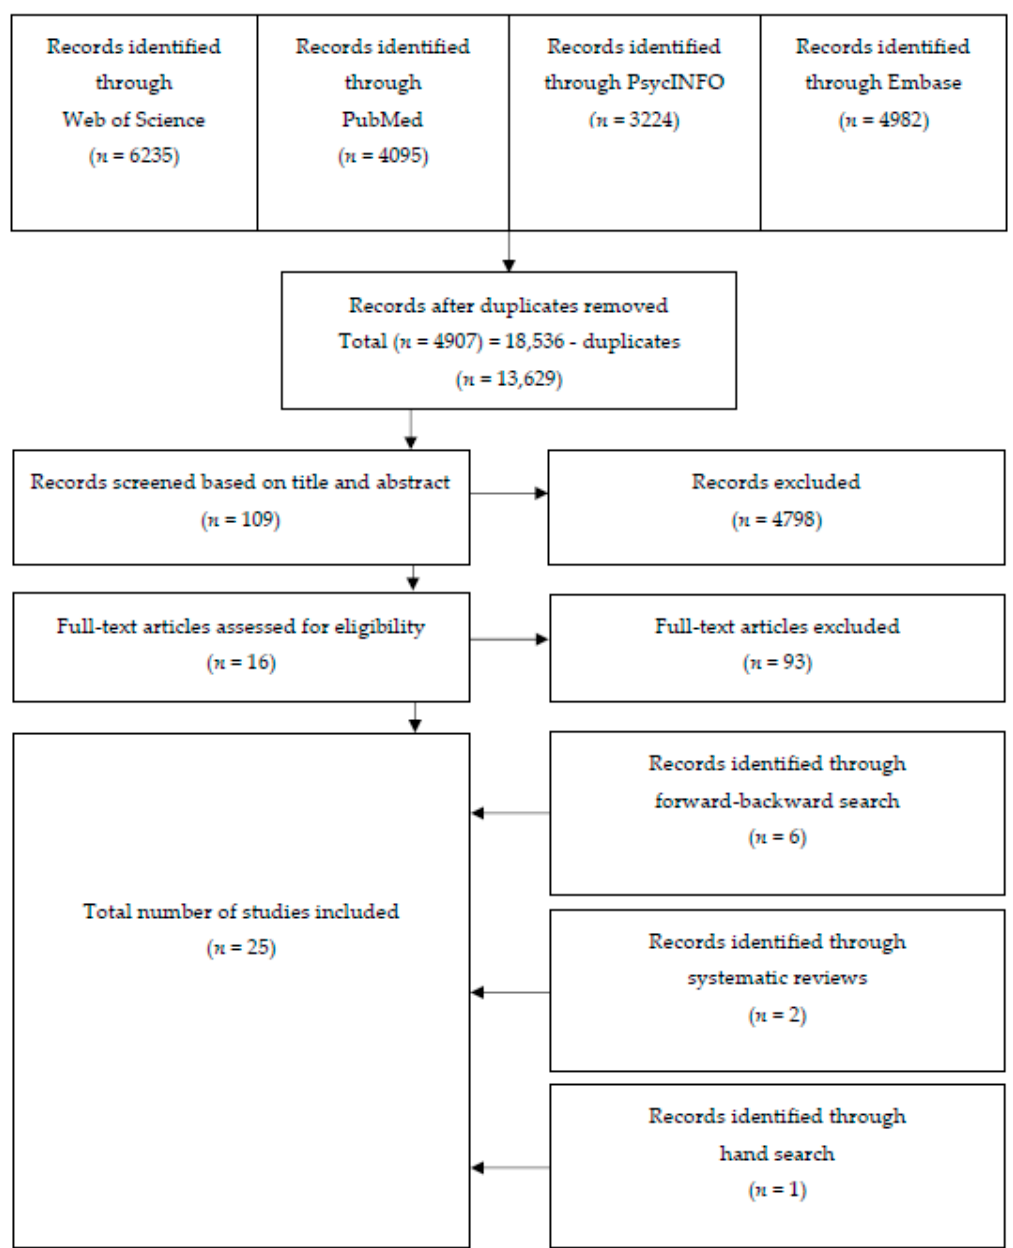
Figure 1. Flow chart of the systematic search.